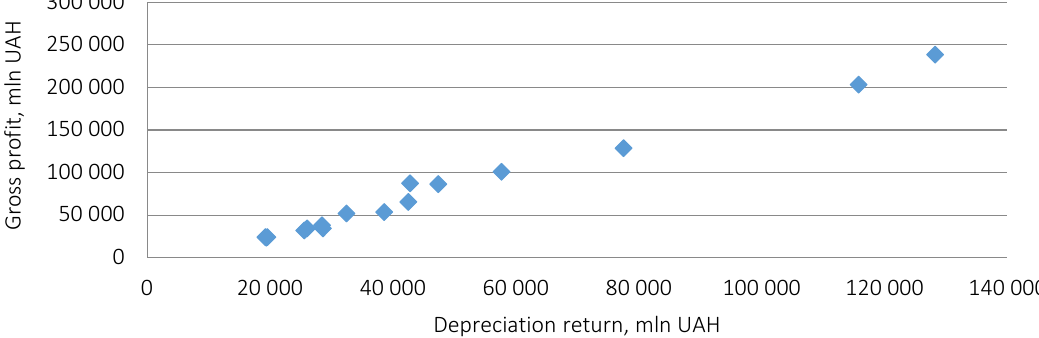
Figure 2. Dependence between agricultural industry gross profit and depreciation